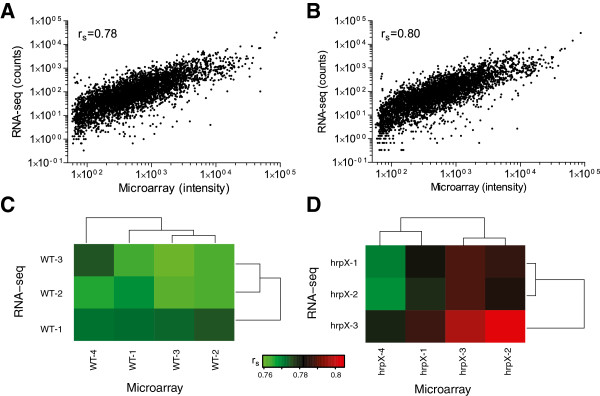
Comparison of absolute levels of gene expression by RNA-seq and microarray. Upper panel shows for the (A) wild-type and (B) hrpX mutant, the correlation between normalized fluorescence intensities of Agilent microarray with the RNA-seq counts from Illumina. Each dot represents the average values for each gene from all the biological replicates. Spearman’s correlation coefficient (rs) is indicated for each comparison. Lower panel shows rs between normalized fluorescence intensities of Agilent microarray with the RNA-seq counts from Illumina for all the combination of biological replicates for the (C) wild-type, and (D) the hrpX mutant. The rs values are plotted in the form of a heat map, where green color represents low rs value, while red represents highest rs value. The dendrogram provides a hierarchical clustering.